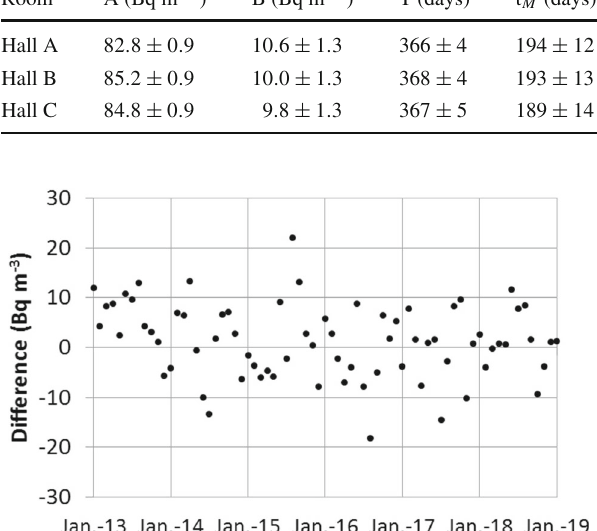
Fig. 5 Differences between the experimental and the fitted values of 222 Rn concentration of hall A to Eq. (2). Corresponding plots for halls B and C are